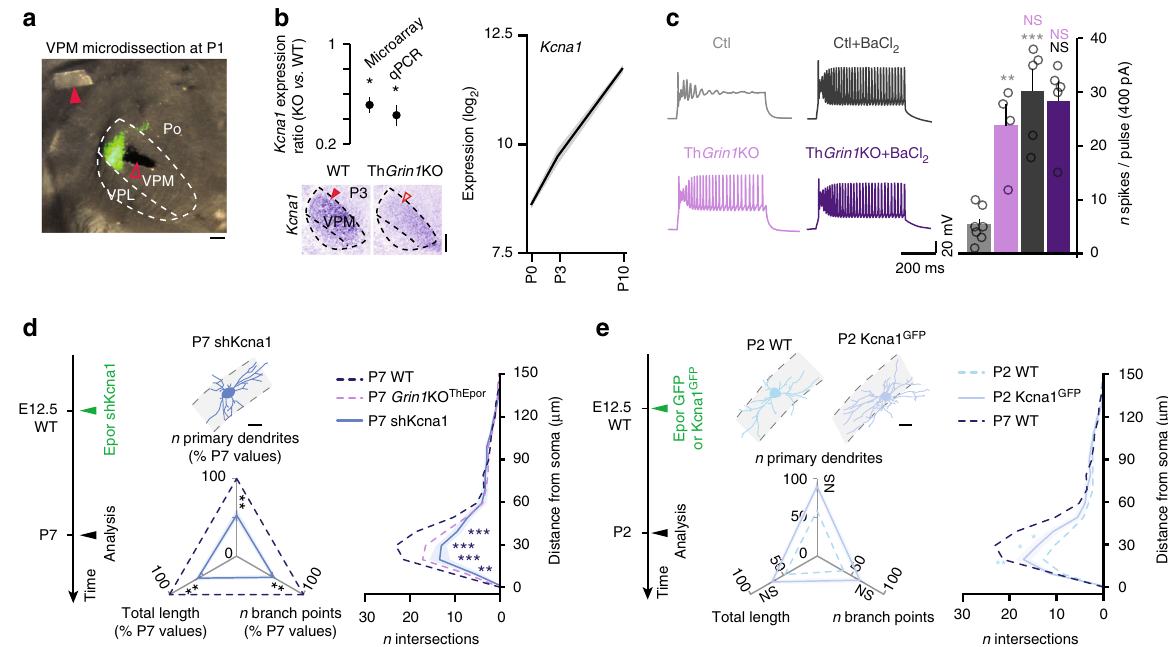
Fig. 2 Kcna1 is a downstream target of NMDARs and controls neuronal excitability and dendritic maturation. a Illustrative microdissection of VPM nucleus at P1. VPM nucleus was identi fi ed by retrograde labeling from S1 (green labeling). Red arrowheads show the microdissected specimen and its original location. Scale bar: 100 μ m. b Top left: Kcna1 expression is decreased in Th Grin1 KO ( n = 3). Red arrowheads show the labeling in VPM. Student ’ s t -test, * P < 0.05. Bottom left: in situ hybridization shows decreased Kcna1 expression in Th Grin1 KO VPM ( n = 3). Scale bar: 200 μ m. Right: Kcna1 expression increases during development. c At P15, Th Grin1 KO VPM neurons are hyperexcitable; this occludes the effects of the K + channel blocker BaCl 2 . (Ctl n = 7, At P7, dendritic maturation is impaired by Kcna1 down-regulation (P7 shKcna1 n = 8 from 2 mice). P7 WT and P7 Grin1 KO ThEpor data reported from Fig.